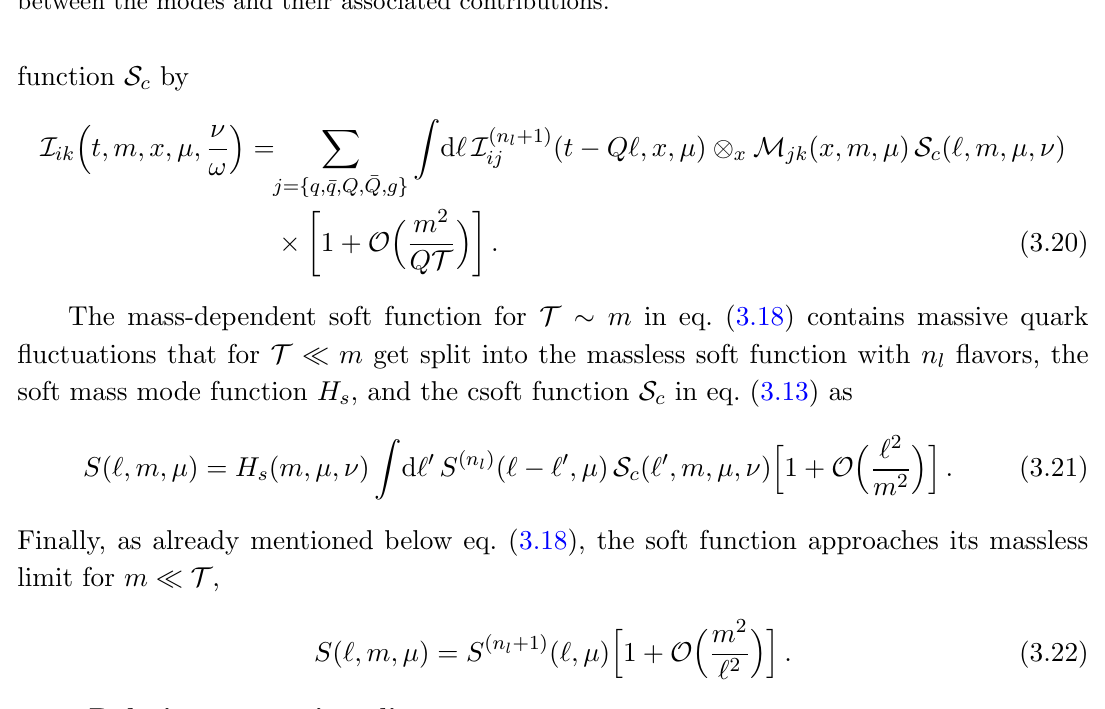
Q for di(cid:11)erent hierarchies T (cid:28) , p Q and Q . The arrows indicate the relations T T